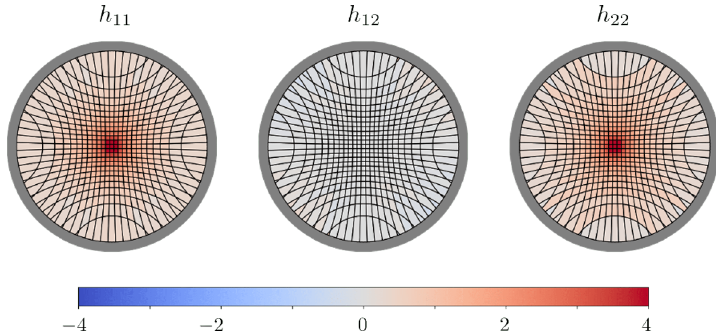
Figure 1. Thermal state reconstruction. Plot shows the individual tensor components h 11 , h 12 , h 22 of the metric perturbation from left to right, respectively. The boundary relative errors are E bdy . 10 − 2 across a wide range of